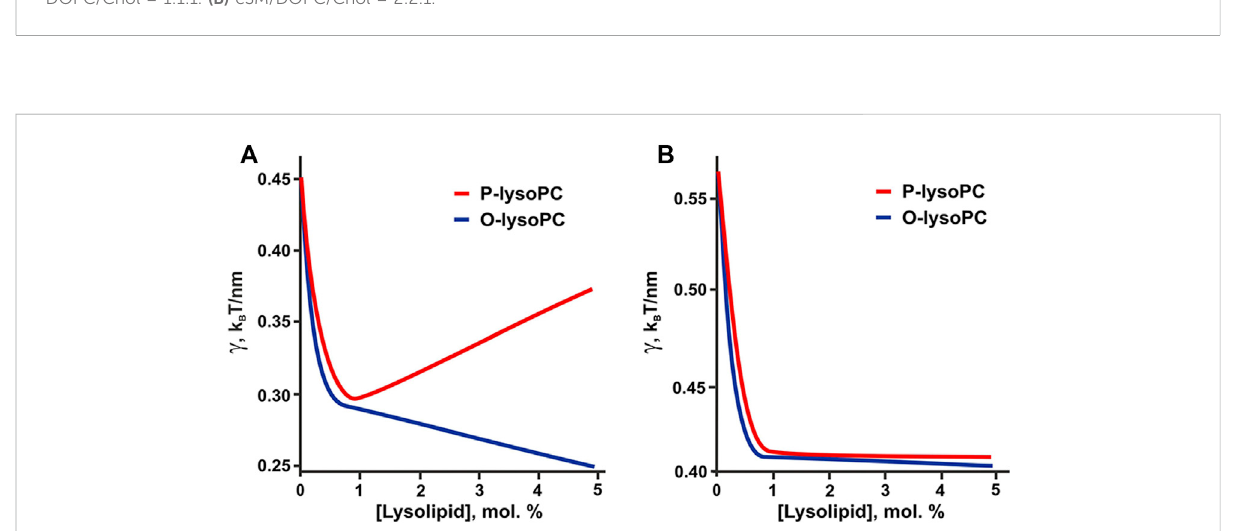
FIGURE 7 Calculated dependence of the line tension of the raft boundary on the total lysolipids content in the eSM:DOPC:Chol membrane for experimentally measured spontaneous curvatures of lysolipids: J OPC = +0.26 nm − 1 , J PPC = +0.15 nm − 1 . (A) eSM/DOPC/Chol = 1:1:1. (B) eSM/DOPC/ Chol =